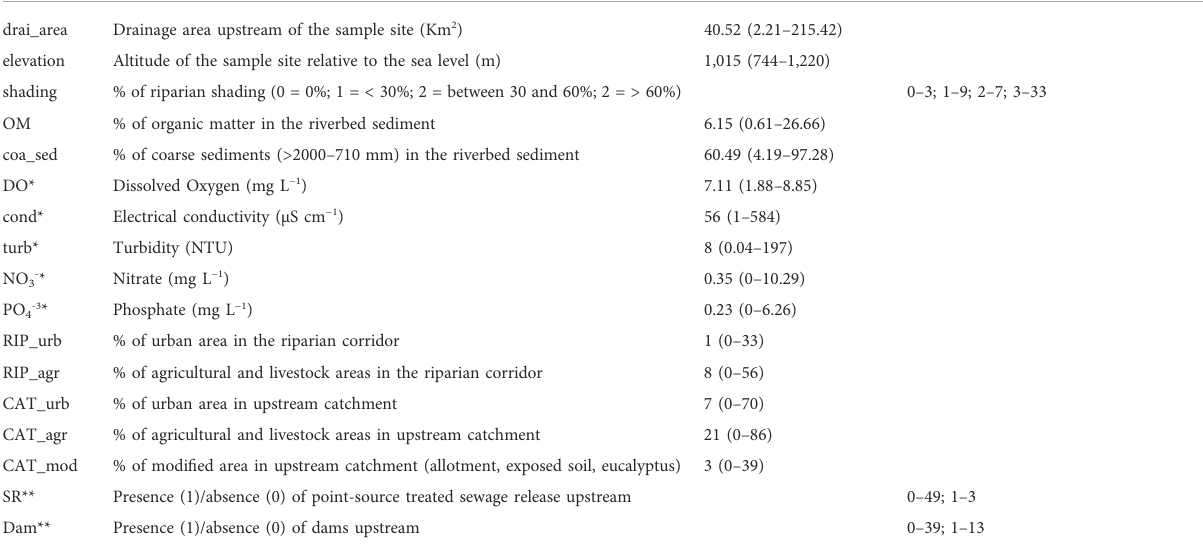
TABLE 1 Description, average and range (minimum and maximum) of natural and human disturbances variables. (*) Data collected four times, but for analysis,weconsidertheaveragebetweenApril/MayandAugust/September.(**)Forcategoricalvariables,weindicatedthenumberofsamplesin each